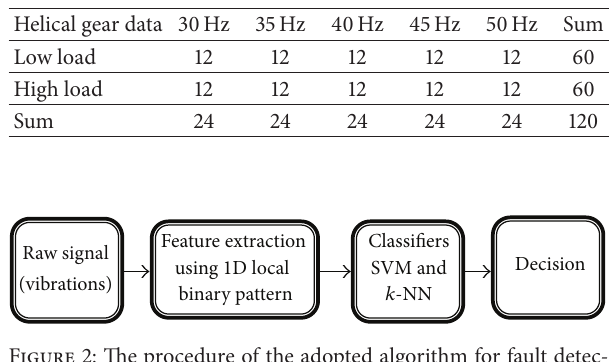
Table 1: The adopted helical gear data distribution on speeds and loads.